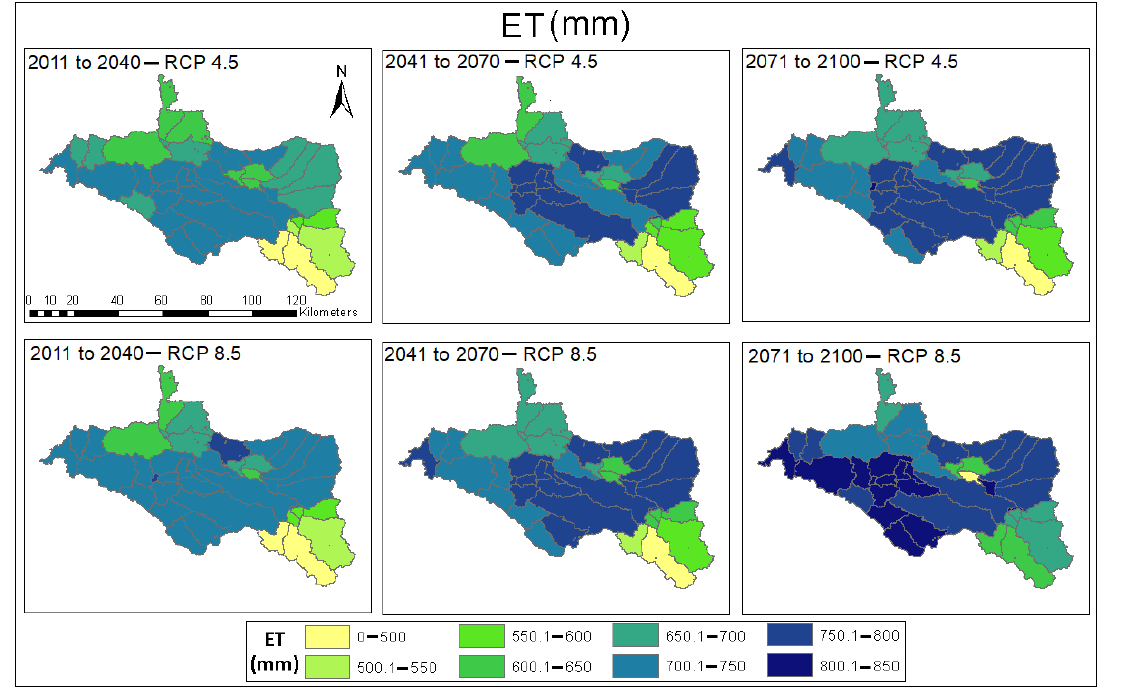
Figure 10. Spatial distribution of evapotranspiration for near, mid-, and far future of RCP 4.5 and 8.5 emission scenarios .